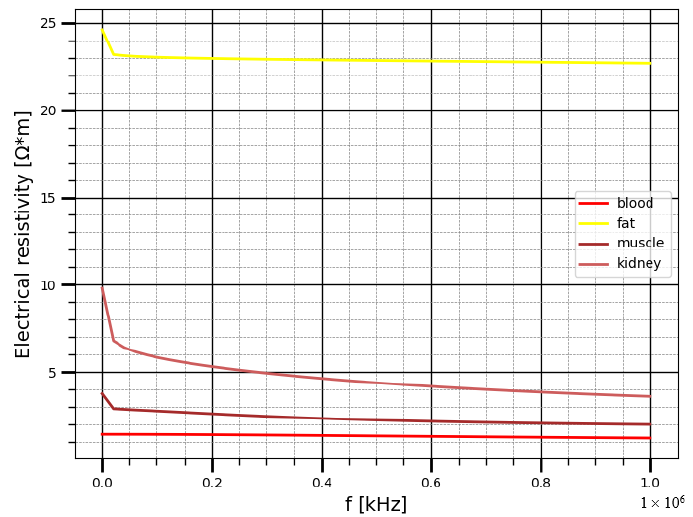
Figure 1. The electrical resistivity of the biological tissues in the study area.